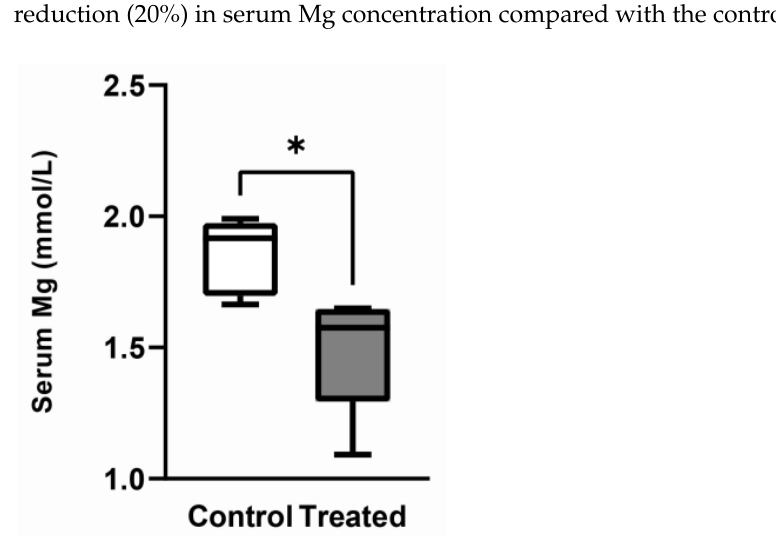
5 of 14 Figure 1. Body weight gain. Mice were fed either a normal (control) or a Mg-deficient diet (treated).